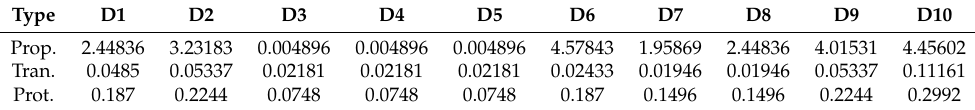
Table 12. P2P total delays: Data concentrators and its corresponding RTUs (in ms).